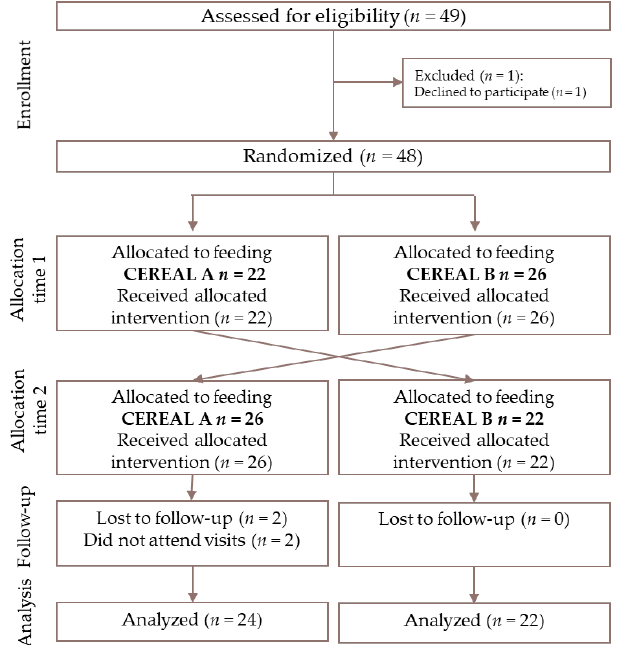
Figure 2. Consort flow chart adapted to cross-over design. Cereal A—0% whole grain and 24 g / 100 g sugar; Cereal B—50% whole grain and 12 g / 100 g sugars.